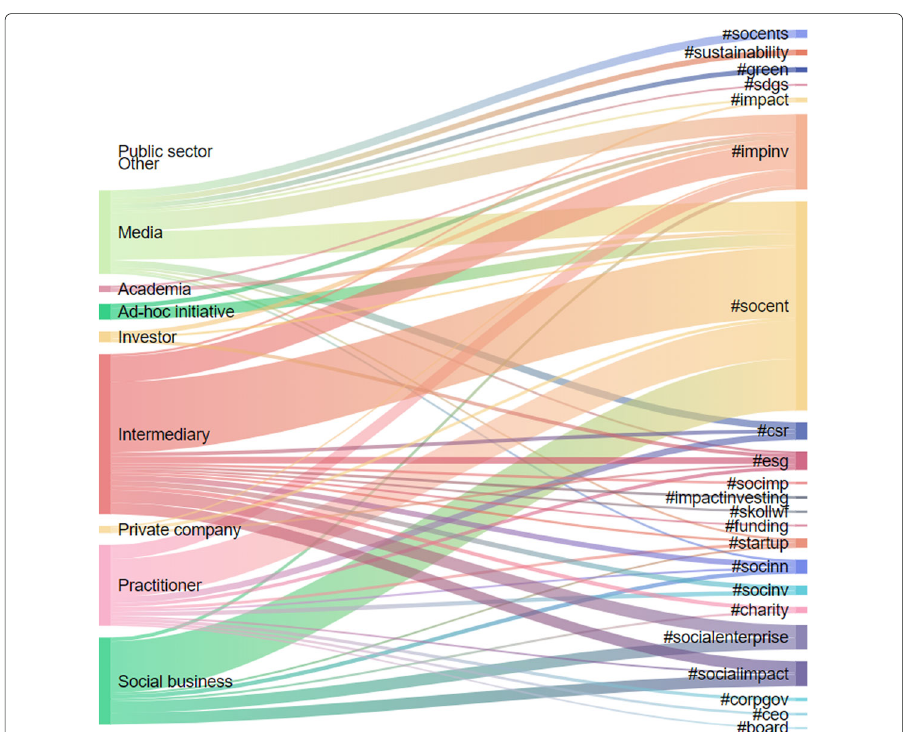
Fig. 4 Mapping of the user categories (left-hand side) to hashtags (righ-hand side). The ten user categories comprise the top 520 influential users. Each hashtags is used at least 500